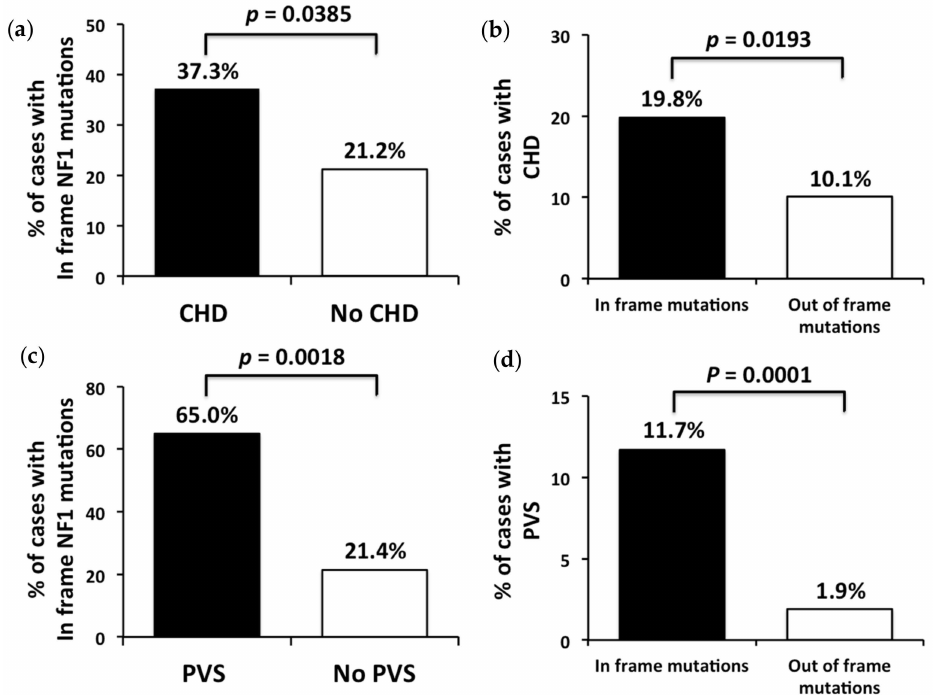
Figure 1. Prevalence of non-truncating mutations in individuals with intragenic NF1 mutations stratified according to the presence / absence of an unspecified congenital heart disease (CHD), or solely based on the presence / absence of pulmonary valve stenosis (PVS), and prevalence of CHD and PVS in individuals with non-truncating NF1 intragenic mutations. ( a ) Increased prevalence of NF1 non-truncating mutations observed among neurofibromatosis type 1 (NF1) individuals with CHD compared with those without CHD. ( b ) Increased prevalence of CHD among NF1 individuals with intragenic non-truncating mutations respect to patients with NF1 intragenic truncating mutations. ( c ) Increased rate of NF1 non-truncating mutations among NF1 individuals with PVS respect to those without PVS. ( d ) Prevalence of PVS in individuals with NF1 intragenic non-truncating mutations respect to those with intragenic truncating